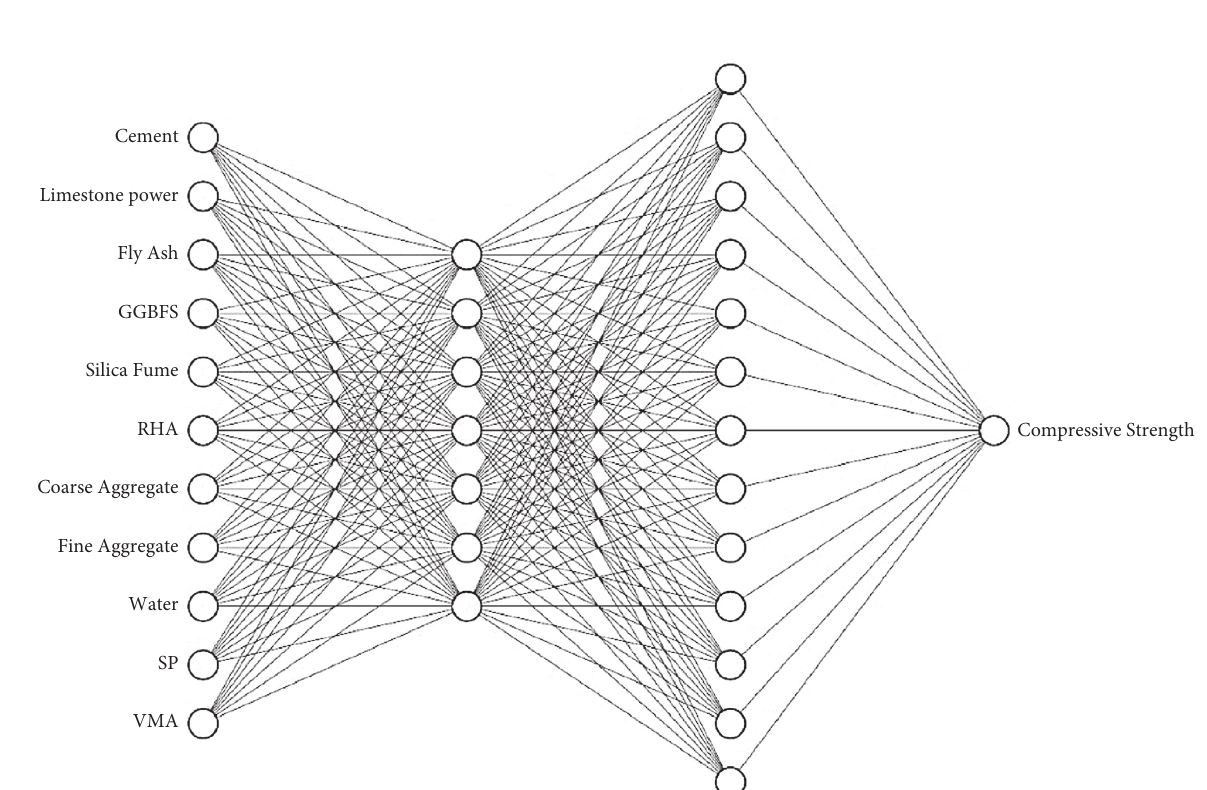
Figure 2: The present ANN architecture comprising 11 input neurons, 7 neurons in the first hidden layer, 13 neurons in the second hidden layer, and a single neuron in the output